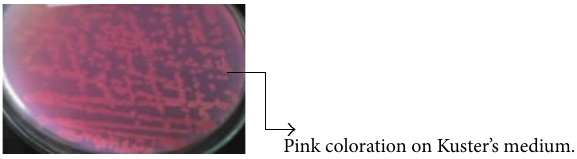
Figure 1: The results of plate assay method for qualitative determi- nation of enzyme production by the isolate.